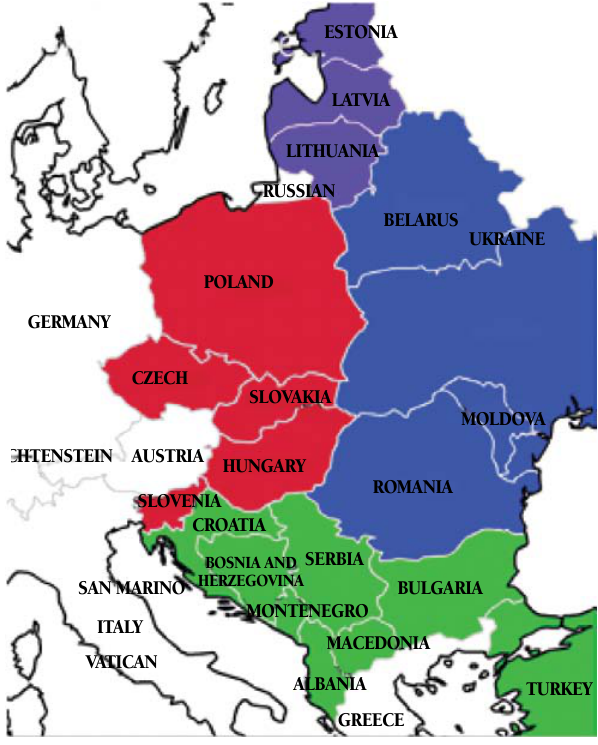
Figure 1 Eastern Europe as subdivided into Northern (purple), Eastern (blue), Southern (green) and Western (red) regions, for the purposes of this